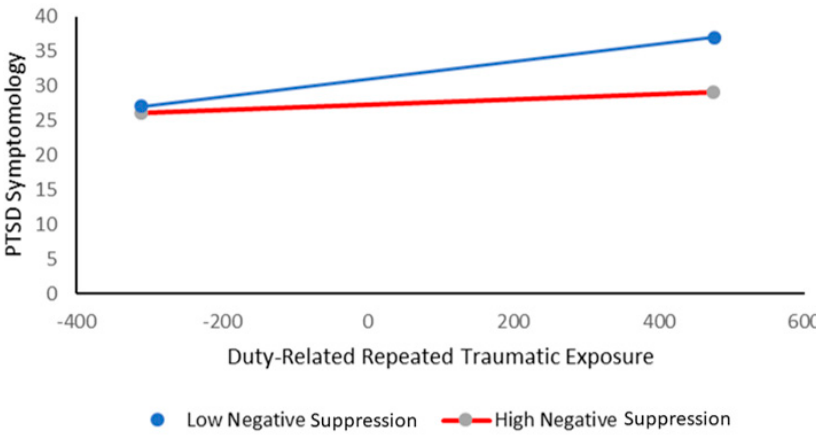
Figure 1. Post-Traumatic Stress Disorder (PTSD) symptomology as a function of duty-related repeated traumatic exposure and negative suppression.